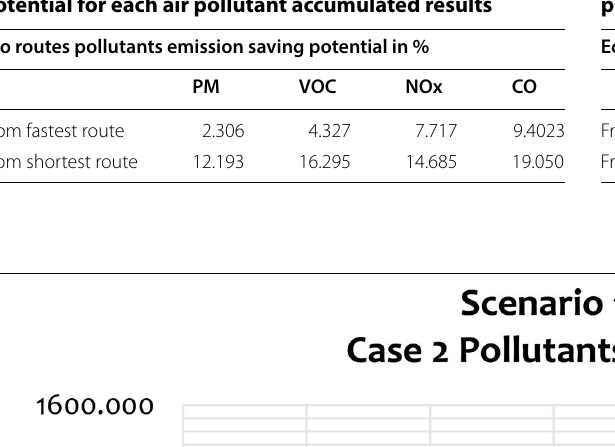
Table 8 Scenario 1 Case 2 eco route emission